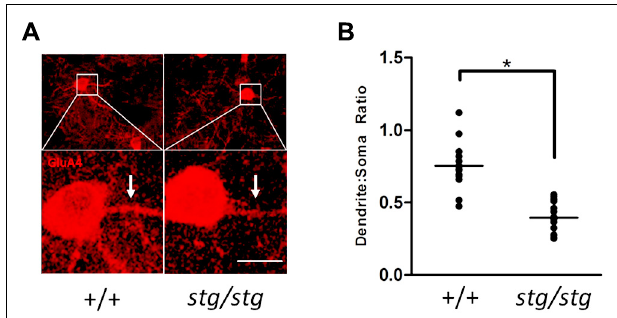
FIGURE 5 | (A) Cortical PV + interneurons in stargazer mutant mice show clear evidence of GluA4 mistrafficking in dendrites. Strong labeling inWT dendrites (arrows) is consistently diminished in stargazer interneurons. A relative decrease in the density of dendritic GluA4 immunoreactivity can be demonstrated by comparison of the dendrite:soma immunostaining ratio in stargazer interneurons compared toWT interneurons (scale = 10 μ m). (B) Quantification of mean dendrite:soma ratio of GluA4 staining reveals a significant decrease in mutant PV + interneurons (mean ratio of 0.753 for + / + , n = 15, vs 0.396 for stg/stg , n = 18, * p < 0.001).